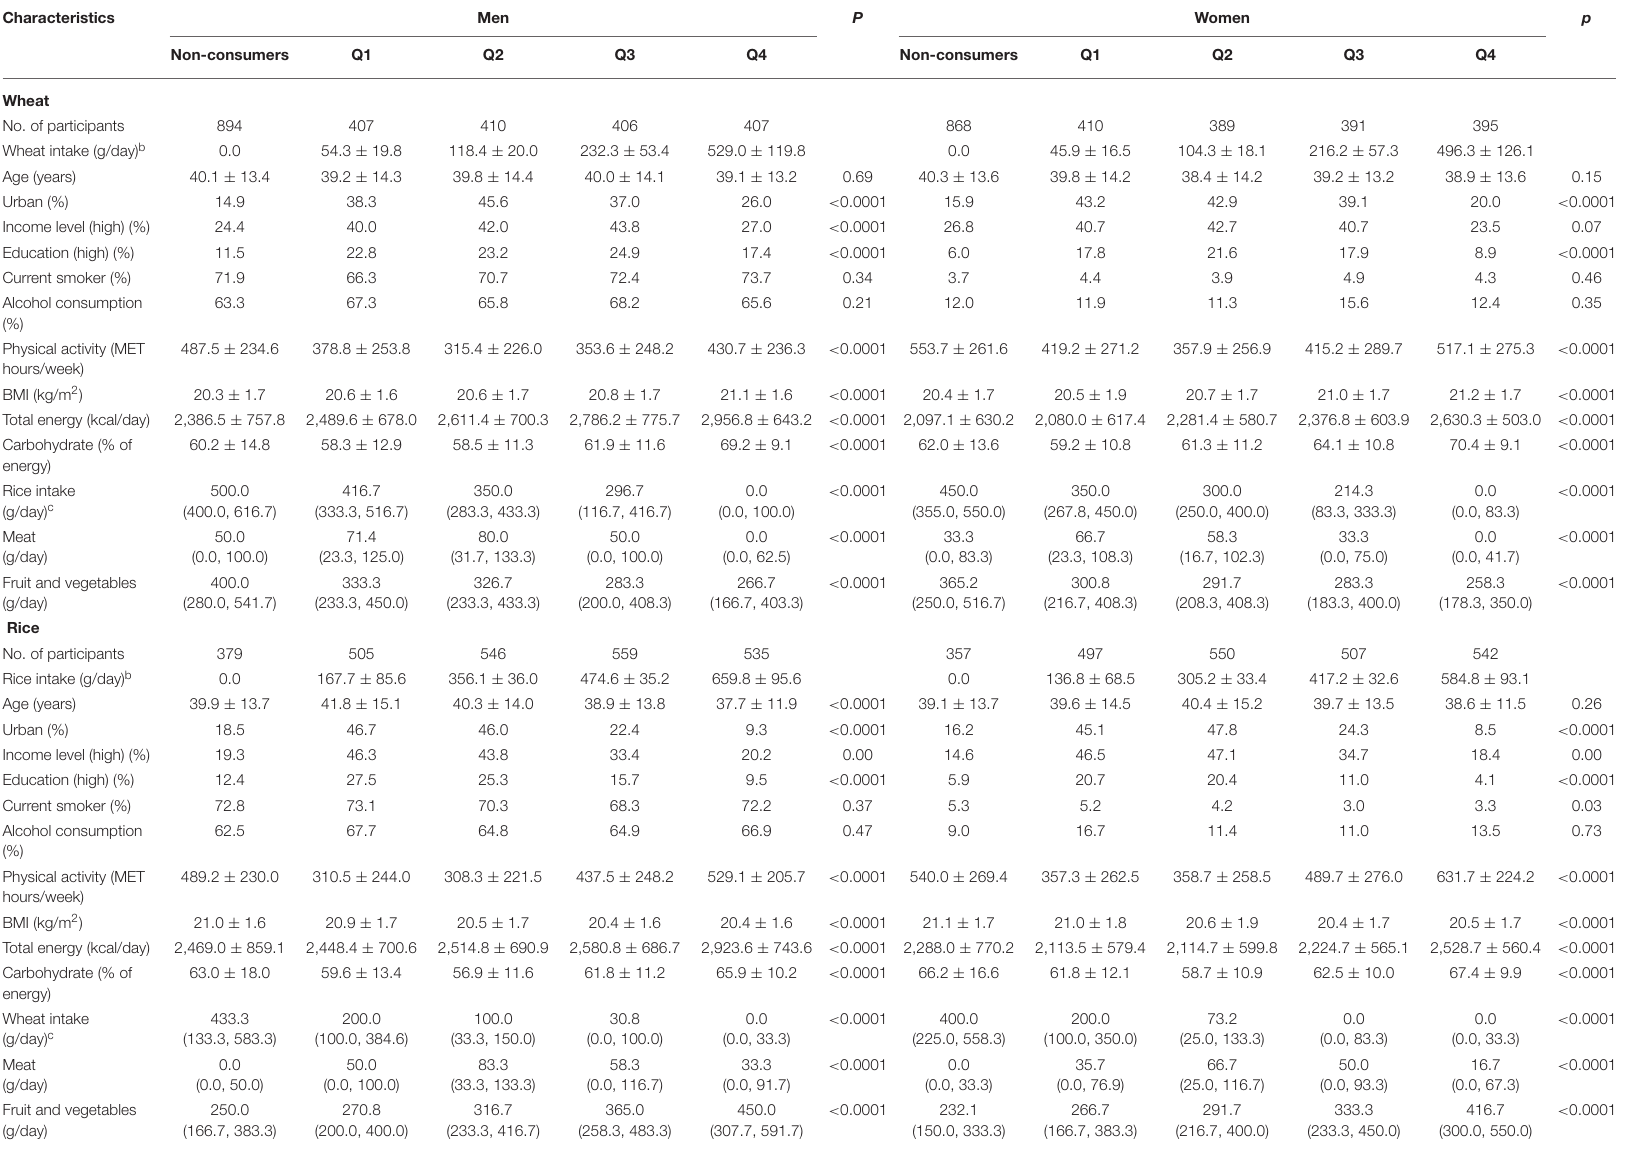
TABLE 1 | Characteristics of participants across five levels of wheat and rice consumption by gender; China Health and Nutrition Survey (CHNS) 1991 a .